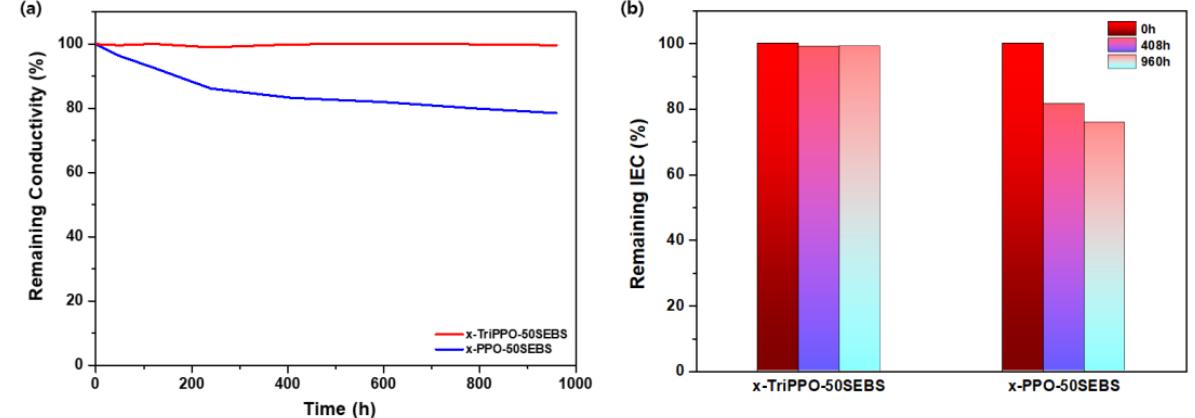
Figure 8. Reductions during alkaline stability tests in ( a ) hydroxide-ion conductivity and ( b ) the crosslinked PPO–SEBS membranes’ IEC.